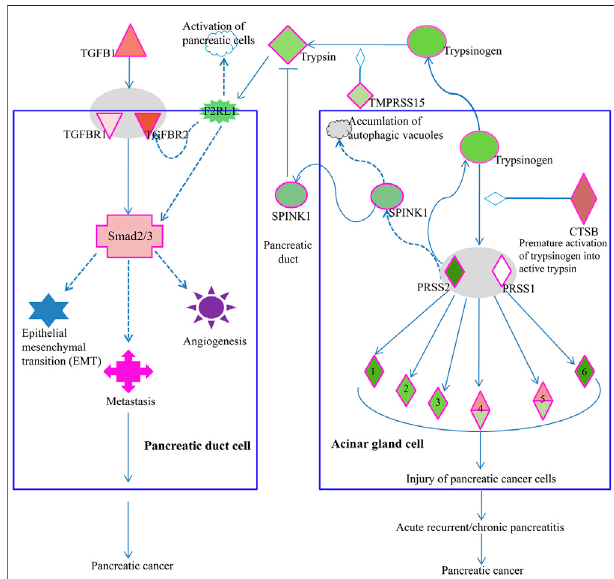
FIGURE 7 | Elements of the SPINK1 pathway are involved in PDAC progression. Acinar gland cells (right) of the pancreas produce trypsin, which in fl uencesthe TGF β signaling pathway inpancreatic duct cells(left). Increased expression of cathepsin B (CTSB) in acinar gland cells will cause premature activation of trypsinogen into trypsin 1/2 serine protease 1/2 (PRSS1/2), which in turn can activate elastase 1), chymotrypsin 2), kallikrein 3), carboxypeptidase 4), phospholipase 5) and colipase (CLPS, 6). Premature activation of these serine proteases will lead to injury of pancreatic cells, pancreatitis and ultimately, pancreatic cancer. Acinar gland cells also synthesize and export SPINK1, which inhibits trypsin. Thus, in acinar gland cells,SPINK1playsaprotectiverolebyinhibitingprematurelyactivatedtrypsin thus preventing trypsin from causing cellular damage. Premature activation of trypsinogen into trypsin triggers a signaling cascade that causes injury to pancreatic cells. In pancreatic duct cells (left) , trypsin is involved in the activation of coagulation factor II thrombin receptor (F2R) like trypsin receptor 1 (F2RL1). This G-protein coupled trypsin receptor in fl uences the signaling of TGF β receptor 2 (TGFBR2) or of Smad2/3, which is an intracellular signal transducer and transcriptional modulator activated by TGF-beta. Increased expression of TGF β or its receptors triggers a signaling cascade via Smad2/3 processes such as epithelial mesenchymal transition (EMT), angiogenesis, and metastasis, which are associated with cancer